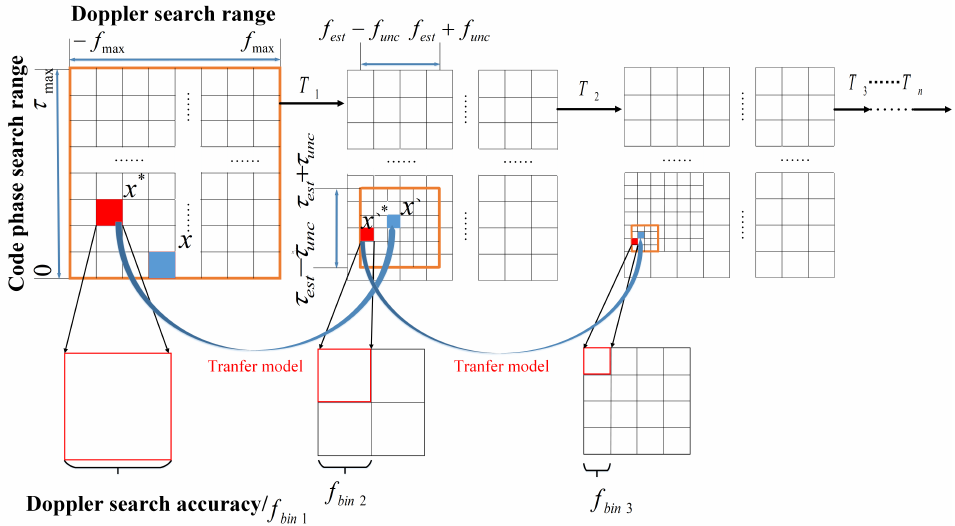
Figure 4. Schematic diagram of the ILS acquisition strategy (The blue unit is the initial solution of the iterative search; the red unit is the neighbor solution of the iterative search; the orange frame is the scope of the iterative search. f est is the Doppler frequency estimated by the transfer model. τ est is the code phase estimated by the transfer model. f unc is the Doppler frequency search range. τ unc is the code phase search range. f bin is the Doppler frequency search